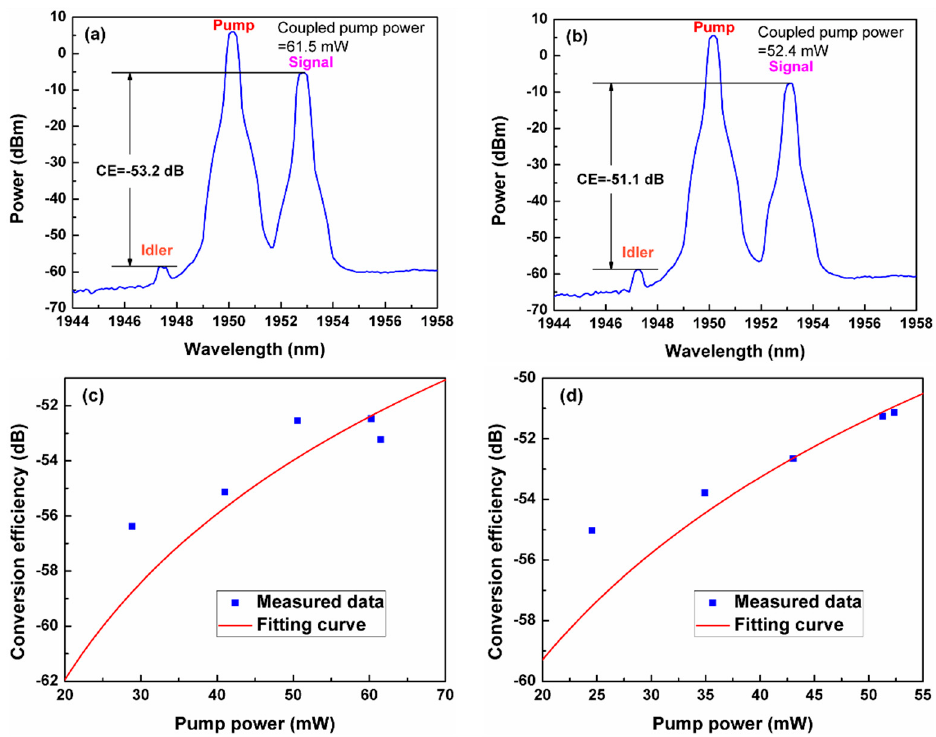
Figure 5. Measured output four-wave mixing spectra ( a,b ) and the wavelength conversion e ffi ciencies with respect to the coupled pump powers ( c,d ) of the fabricated silicon-rich nitride ridge waveguides with a length of 21 mm. ( a ) and ( c ) are for the waveguide with h = 380 nm and w = 950 nm. ( b ) and ( d ) are for the waveguide with h = 640 nm and w = 1320 nm. Table 1. Summary of the linear and nonlinear properties of the fabricated silicon-rich nitride ridge waveguides with various rib heights ( h ) and widths ( w ) at 1950